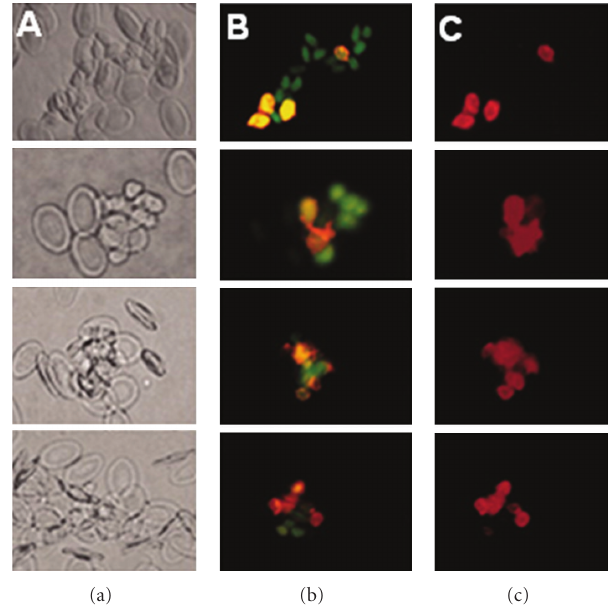
Figure 2: Young and mature thrombocytes forming independent clusters in an aggregation reaction. Top to bottom, the panels show four di ff erent thrombocyte clusters. (a) bright field image; (b) DiI − labeled thrombocytes and mepacrine-labeled thrombocytes as green or orange; (c) DiI-labeled thrombocytes